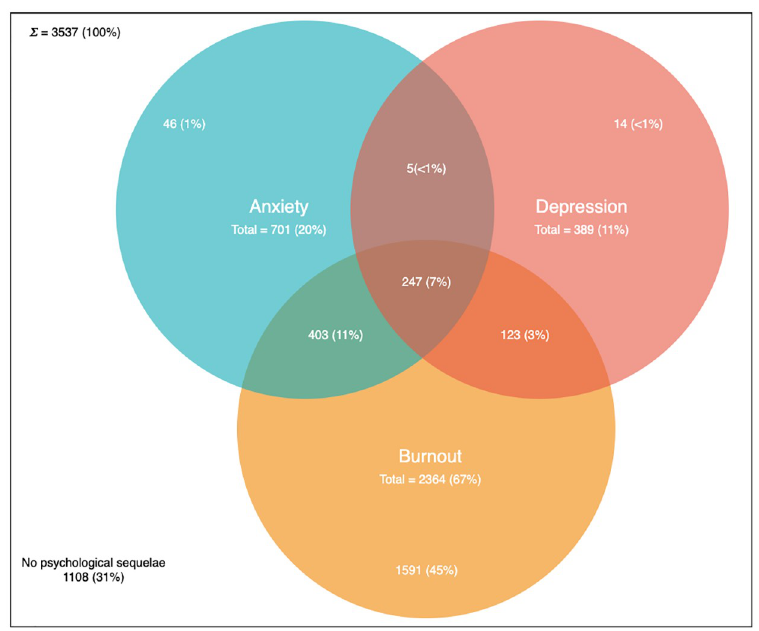
Fig 1. Venn diagram demonstrating prevalence of anxiety, depression and burnout in the sampled population. This figure demonstrates the number of respondents meeting the OLBI criteria for burnout, the HADS criteria for anxiety and the HADS criteria for depression. The overlap of sets represent individuals meeting more than one